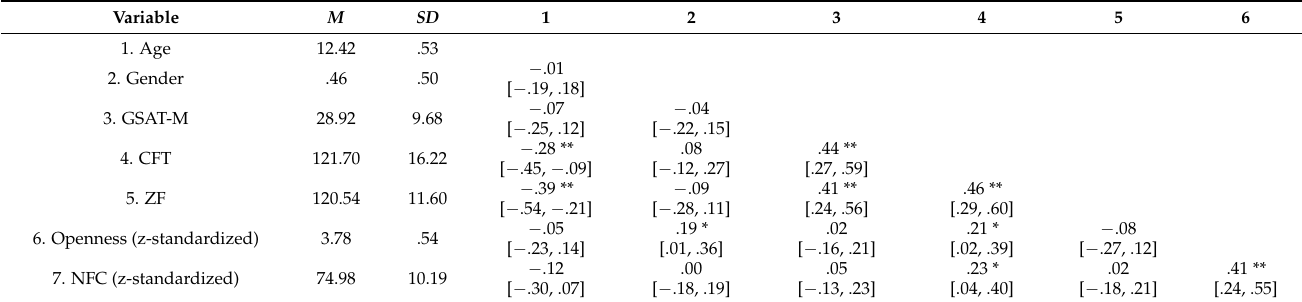
Table 3. Means, standard deviations, and correlations with confidence intervals.